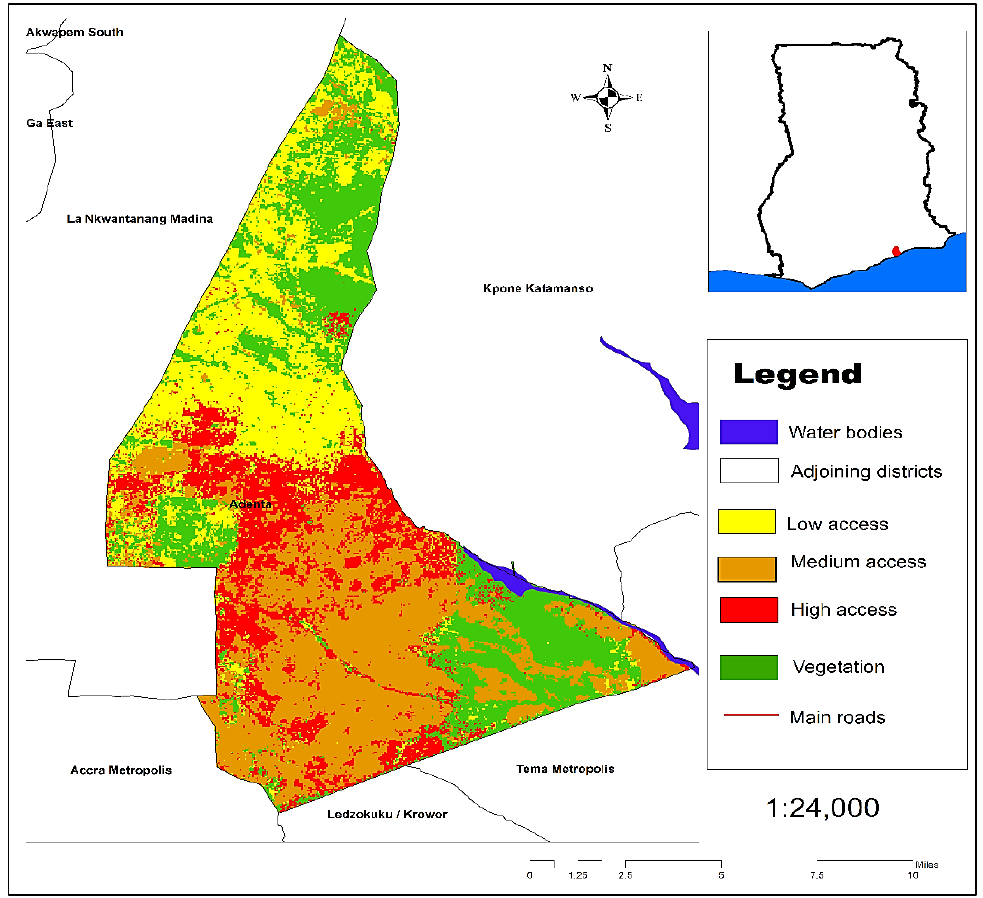
Figure 7. Economic access to food shown in zones (author’s construct).